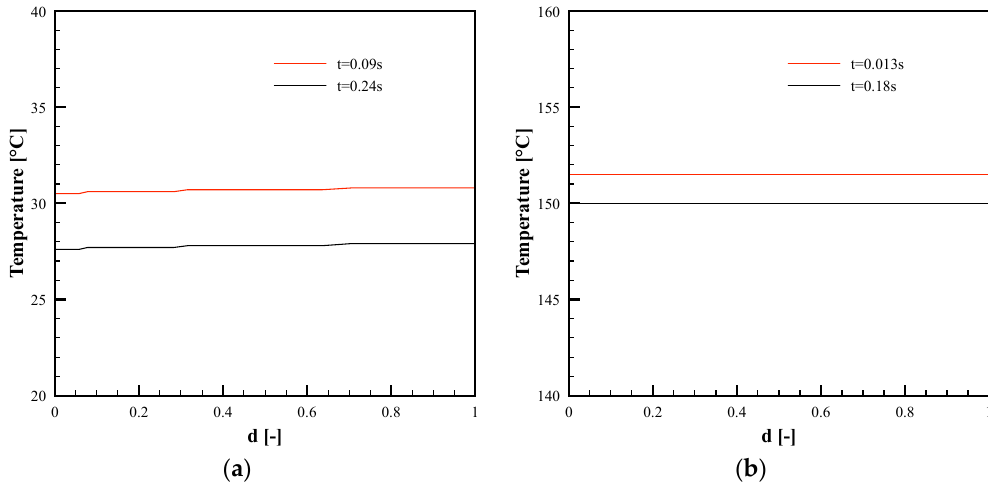
Figure 9. Temperature distributions along the dimensionless half thickness from the corner surface, d, in positions L1 and L3 for Passive condition ( a ) and 150 °C cavity surface temperature condition ( b ).